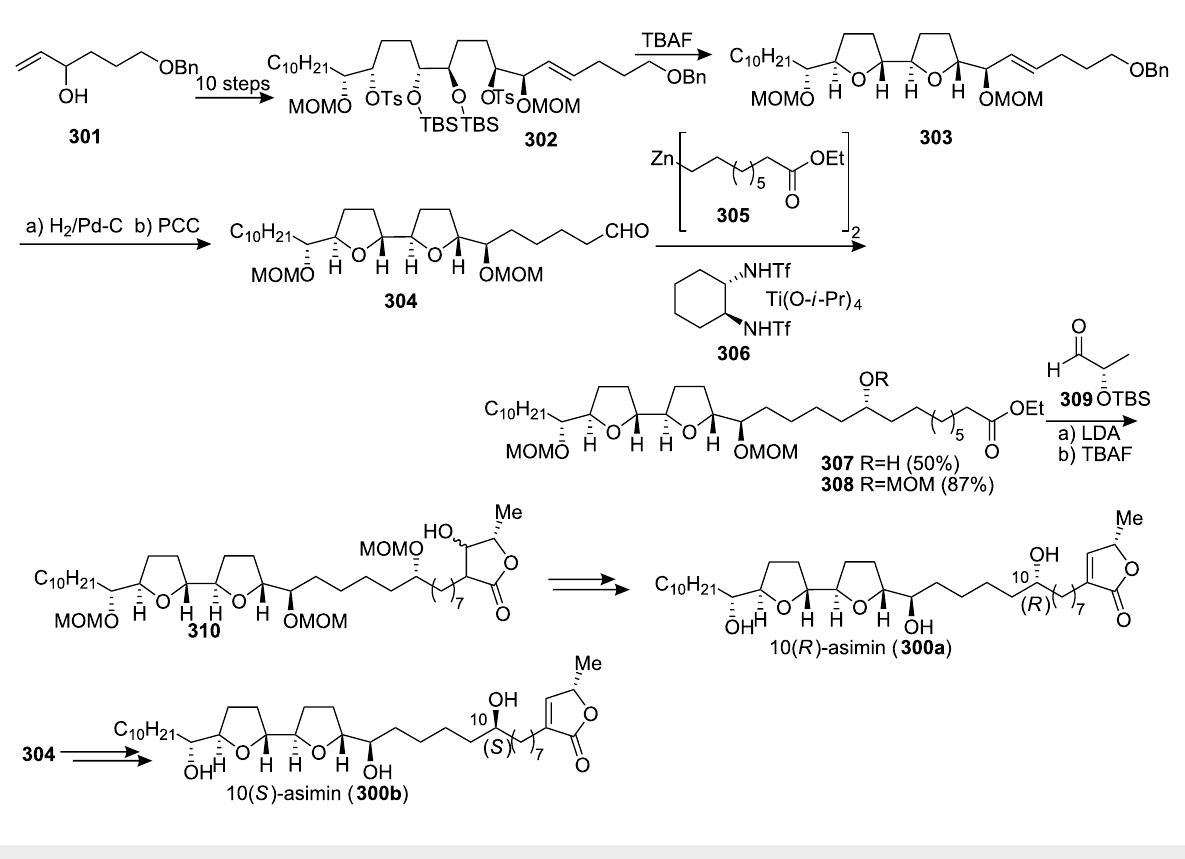
Scheme 41: Total synthesis of asimin by Marshall’s group.